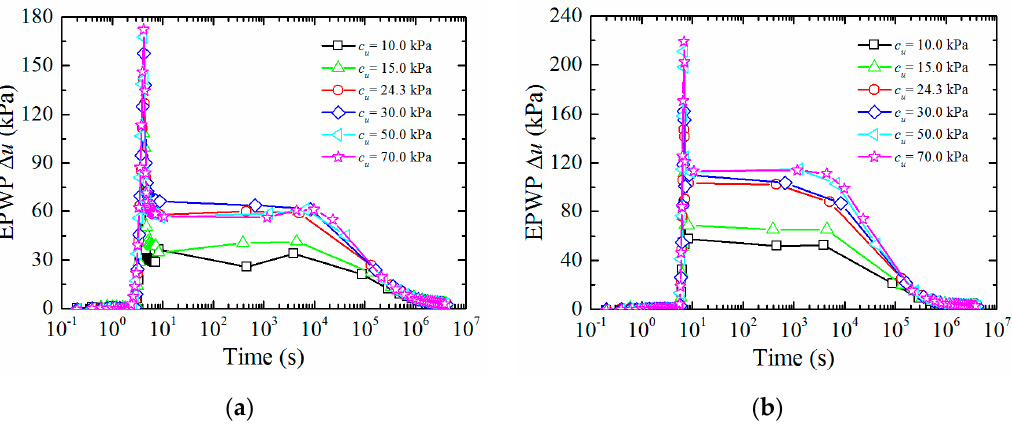
Figure 12. Development and dissipation of EPWPs during and after pile installation under various soil undrained shear strengths. ( a ) At depth of 4.9 m; ( b ) at depth of 7.5 m.